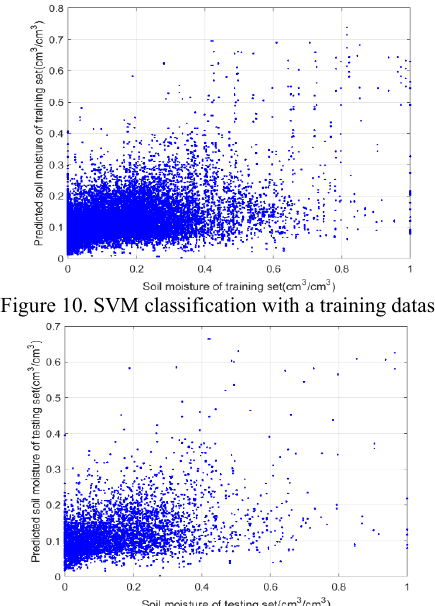
Figure 10. SVM classification with a training dataset